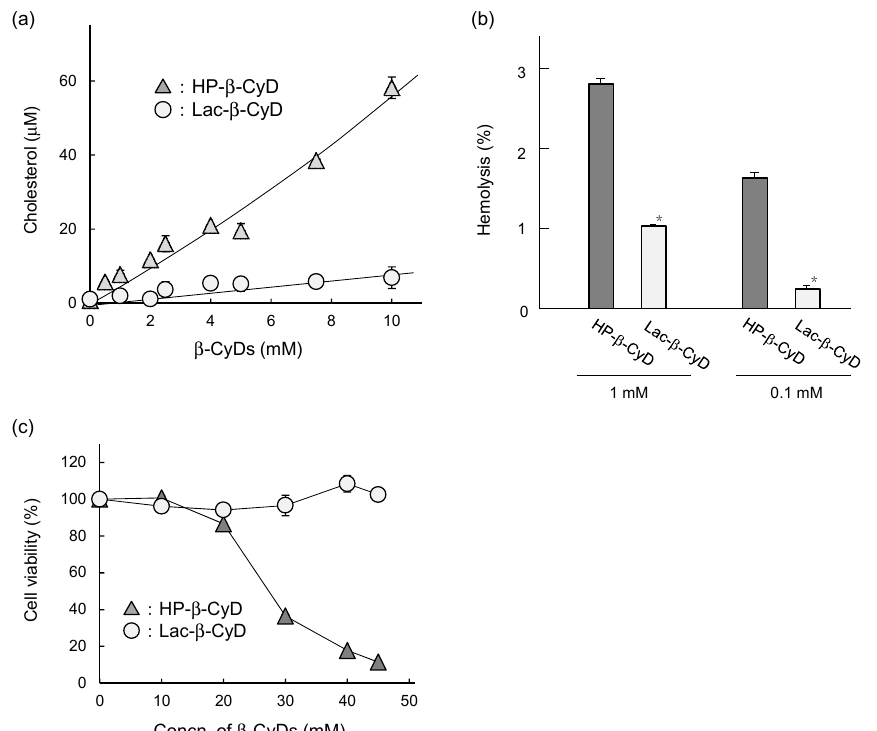
Figure 7. In vitro safety evaluation of Lac- β -CyD. ( a ) Phase solubility diagram of cholesterol with Lac- β -CyD and HP- β -CyD in water at room temperature. ( b ) Hemolytic activity of Lac- β -CyD and HP- β -CyD (at 0.1 and 1.0 mM) in rabbit red blood cells. ( c ) Cytotoxicity of Lac- β -CyD and HP- β -CyD in U18666A-treated HepG2 cells. Cell viability was determined by WST-8 assay. Each value represents the mean ± S.E.M. of 4 experiments. * p < 0.05, compared to HP- β -CyD.